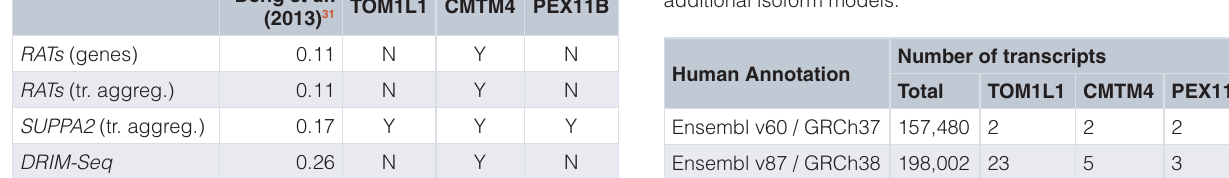
Table 2. Expansion of the human annotation between Ensembl v60 and v87. In total, the later annotation contains 25% more transcript models. The three genes identified by Deng et al. (2013, 31), TOM1L1, CMTM4 and PEX11B, have all acquired additional isoform